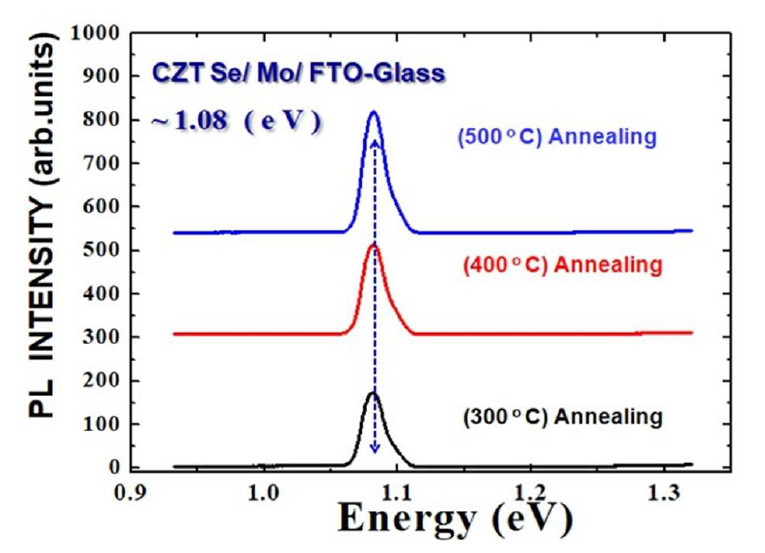
Figure 4. Room-temperature PL spectra of MAPbI 3 deposited on CZTSe/Mo/FTO glass substrates following the annealing treatments at 300, 400, and 500 °C.